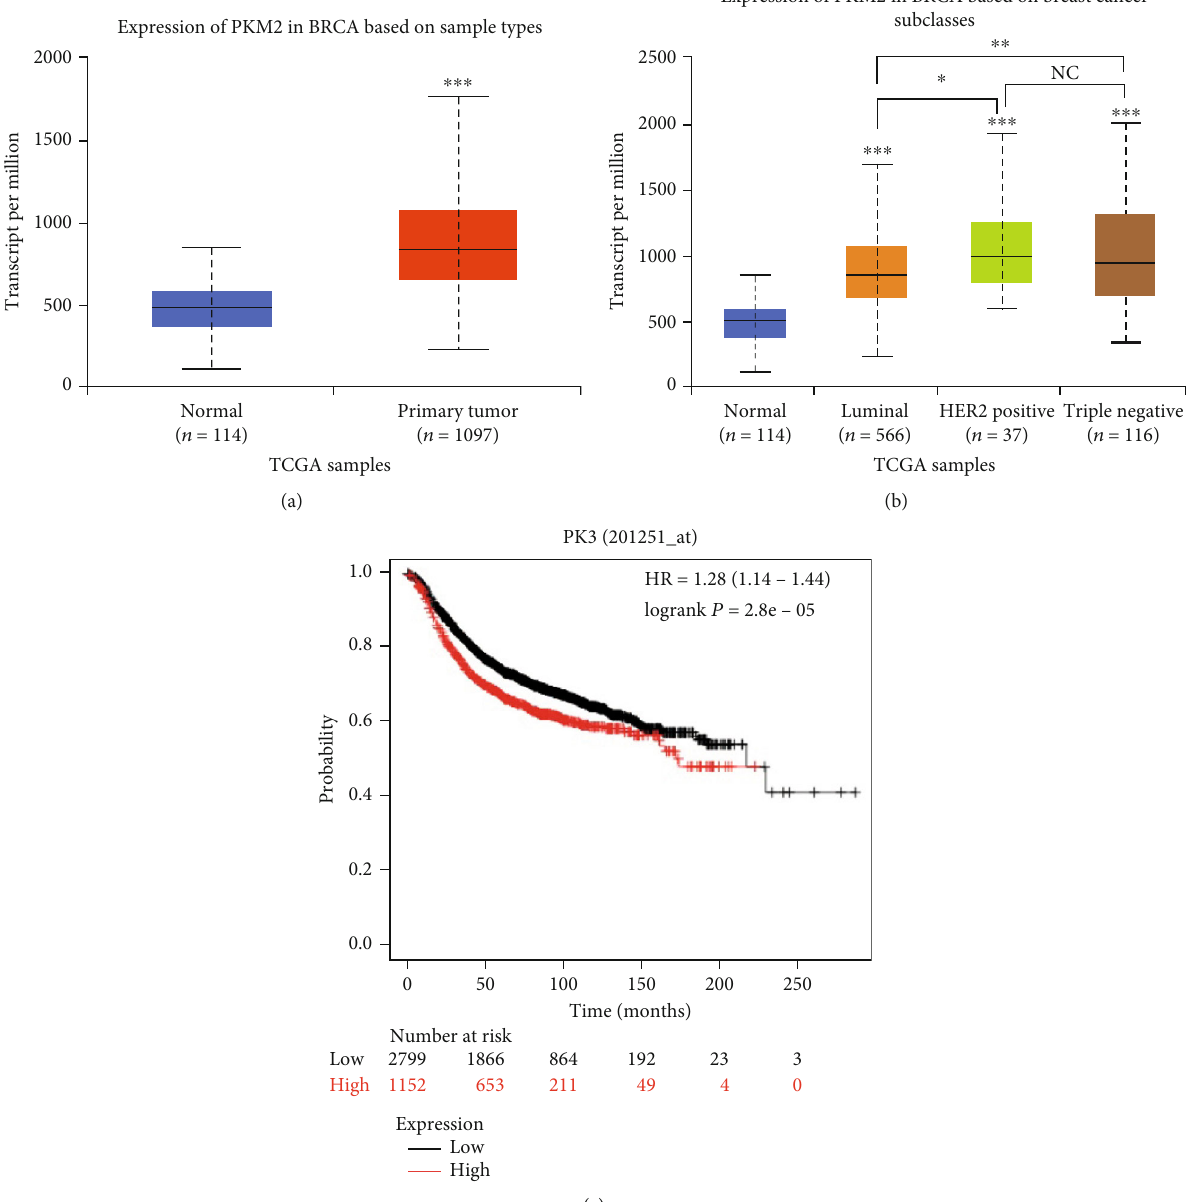
Figure 2: PKM2 expression associates with the prognosis of breast cancer patients. (a) Expression level of PKM2 in normal tissue and primary breast cancer tissues. (b) Expression level of PKM2 in di ff erent subclasses (TNBC, luminal, and HER-2) of breast cancer. (c) Kaplan – Meier curves showed that the patients with higher PKM2 expression had poorer overall survival ( P < 0 : 005 ). Abbreviations: BRCA: breast invasive carcinoma ( ∗∗∗ P < 0 : 001 ; ∗∗ P < 0 : 01 ; ∗ P < 0 : 05 ; NC : P > 0 : 01